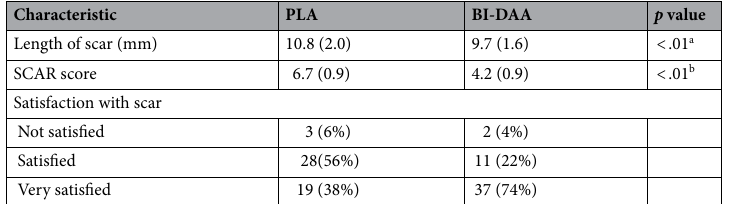
Table 5. Post-Operation Scar and Wound Evaluation. Values are n (%) or mean (SD). p value < 0.05 considered statistically significant. BI-DAA bikini incision via direct anterior approach, PLA posterolateral